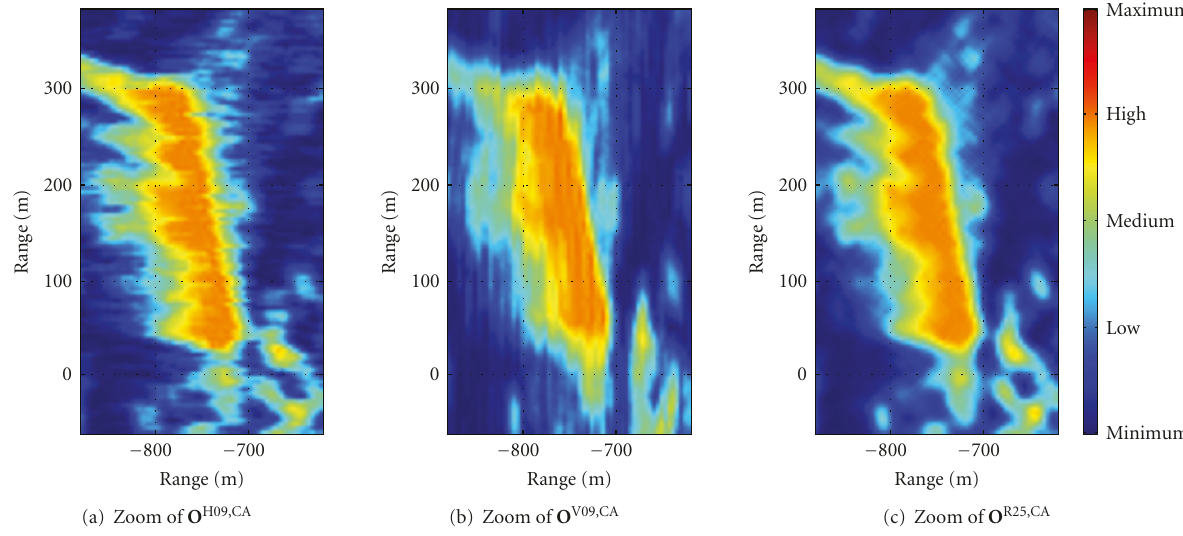
Figure 11: Zoom of the Images Processed by the CA System Using its Best H, V, and R Integration Modes.